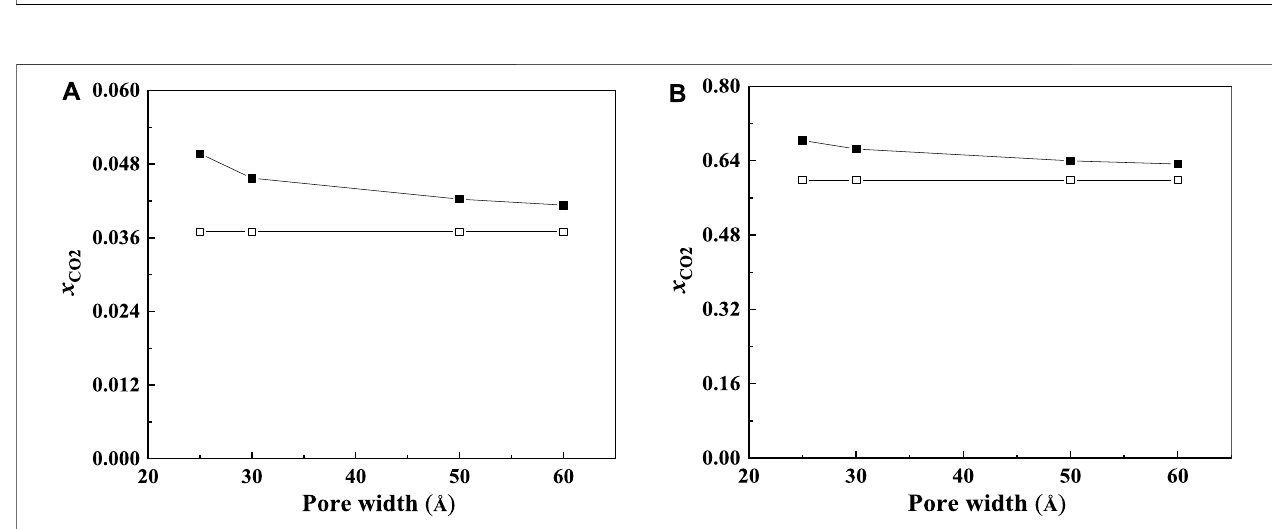
FIGURE10| Calculated CO 2 solubility of[C 6 mim] [Tf 2 N] at 298.15 K and 1 bar (A) and30 bar (B) inslit-shaped pores withdifferentwidths (solid symbols,data for con fi ned ILs; open symbols, data for bulk ILs.).